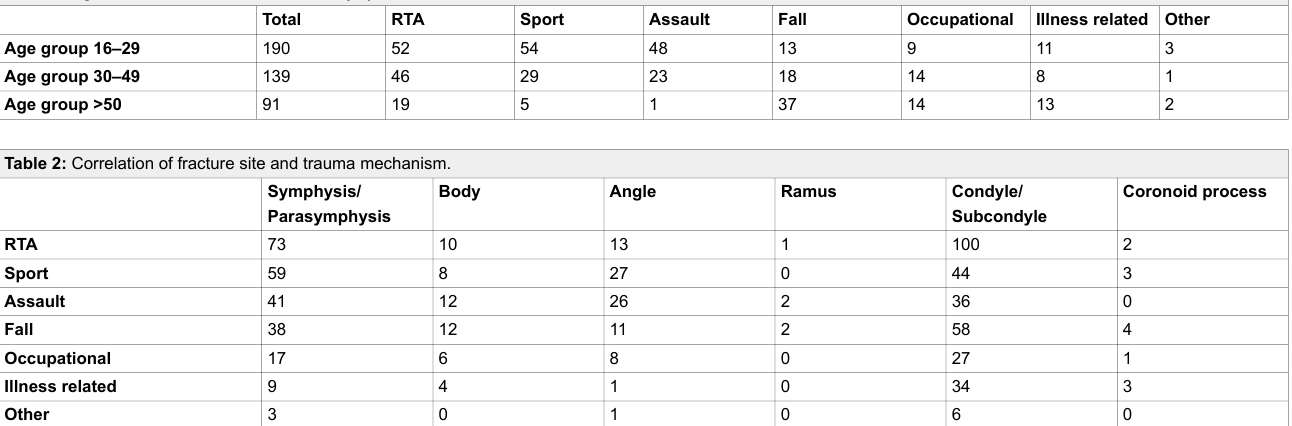
Table 1: Age distribution and mechanism of injury.